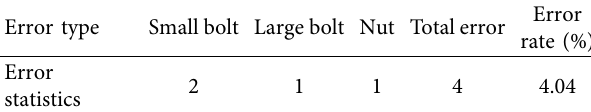
Table 3: Statistics of strong classifer recognition results.